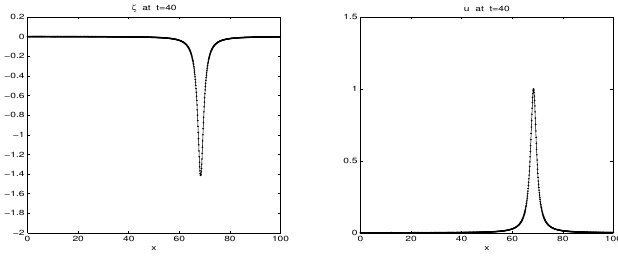
Figure 2. In points: approximate solitary wave solution (5.30)–(5.31). In solid line: solution ( ζ num ,u num ) obtained with the numerical solver.